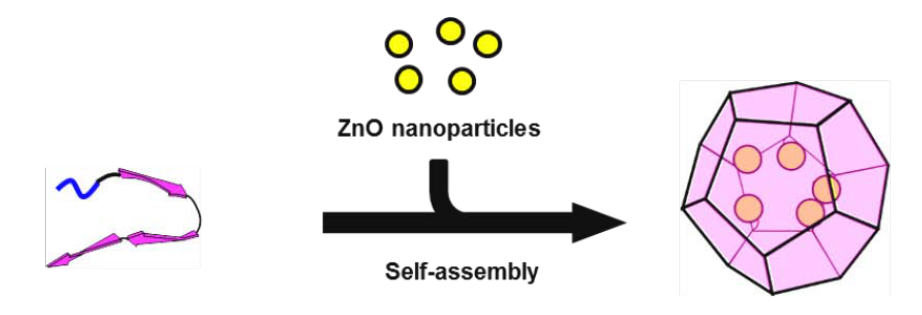
Figure 1. Schematic illustration of the inclusion of ZnO nanoparticles in nanocapsules self-assembled from ZnO-binding β-annulus